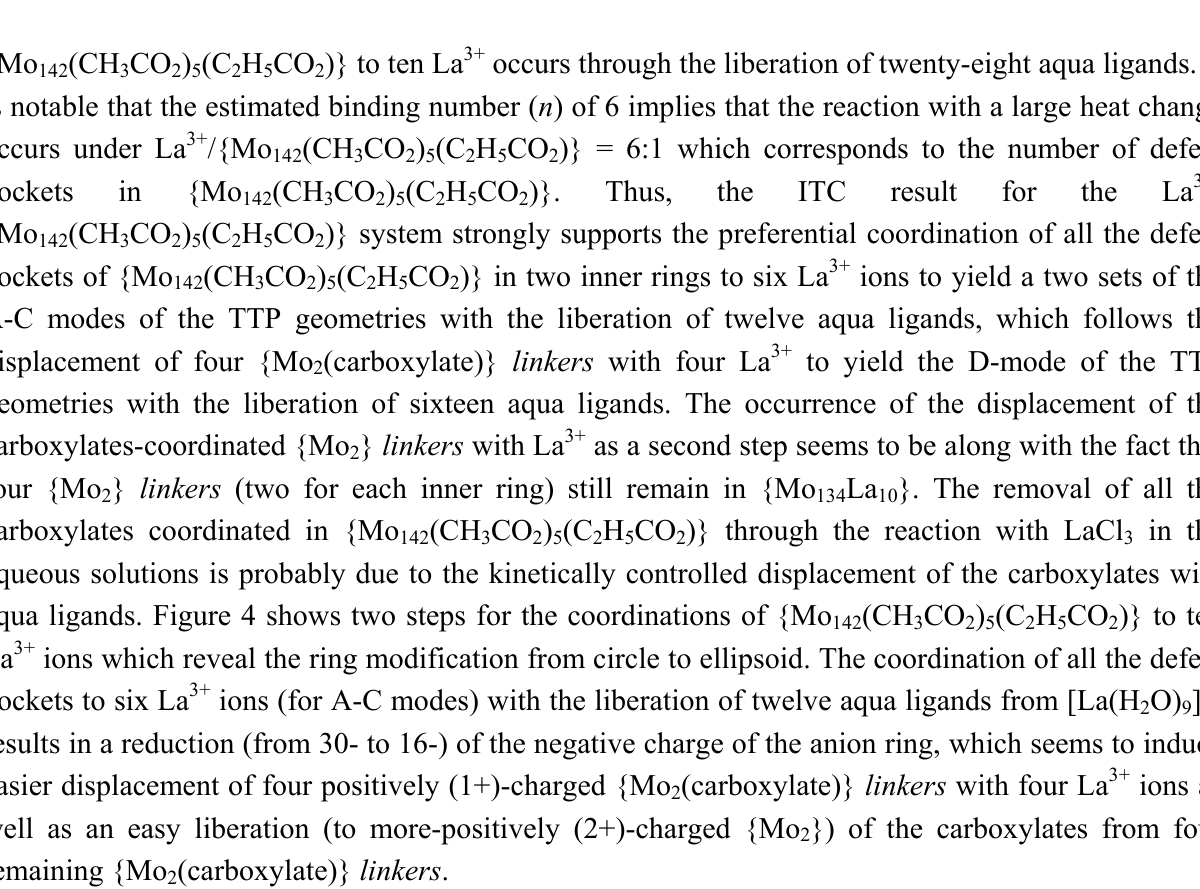
(CH CO ) (C H CO )} to La 3+ in 142 3 2 5 2 5 2